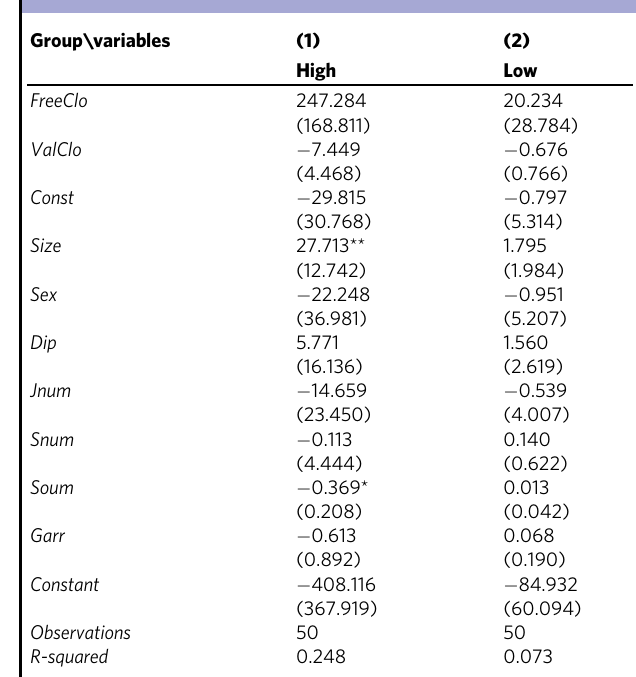
Table 5 Regression results from the perspective of heterogeneity of herding behavior